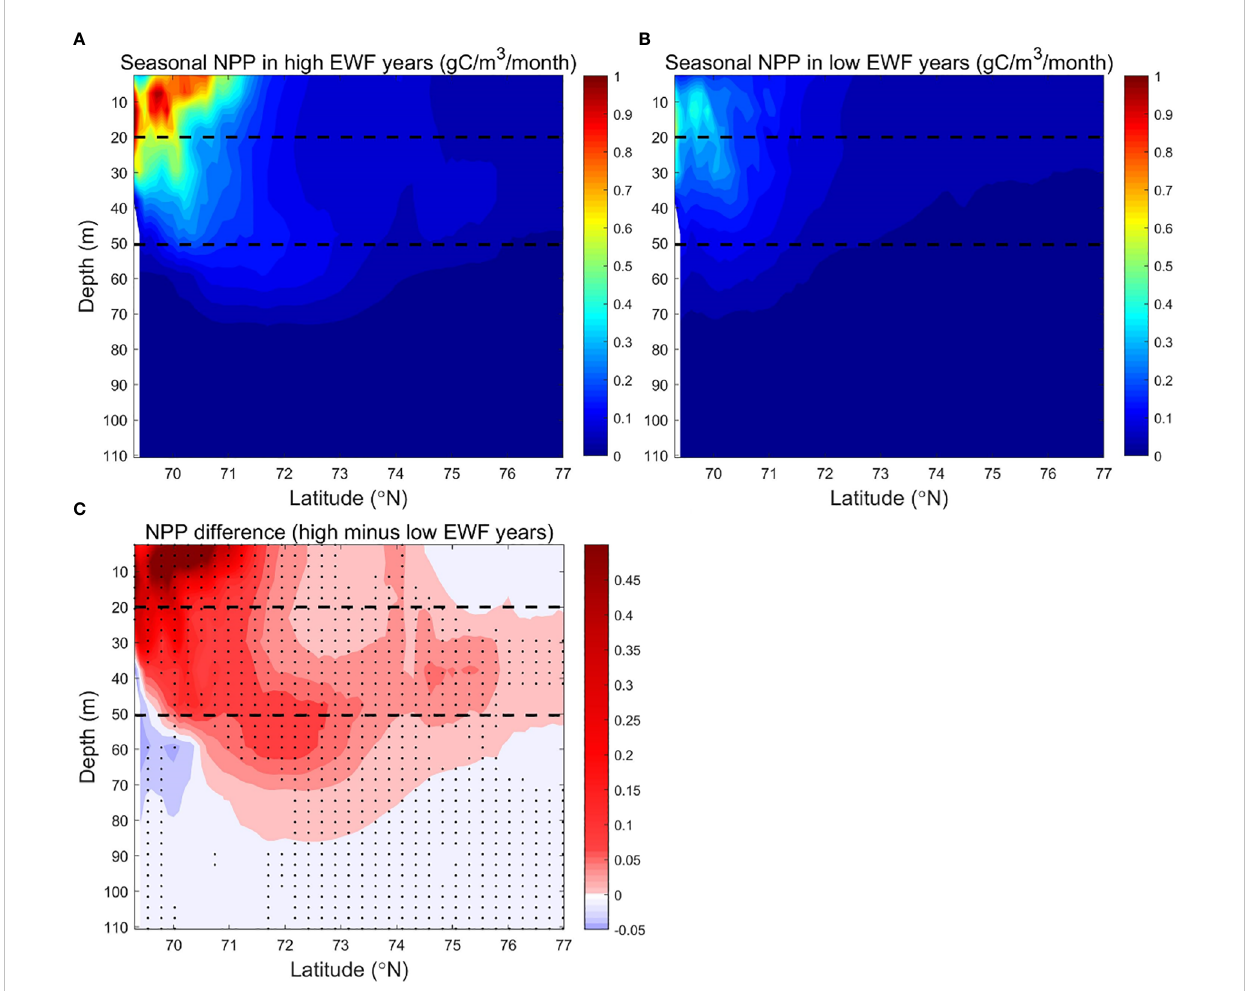
FIGURE 11 Modeled seasonally (June to September) averaged NPP (g C/m3/month) in the BC in (A) high (1998, 2007, 2008, 2010, 2011) and (B) low (1991, 1992, 1994, 1996, 2002) EWF yeas, and (C) their differences (high minus low). The dashed lines denote 20 m and 50 m depth separately. In Figure 11C, black dots denote where